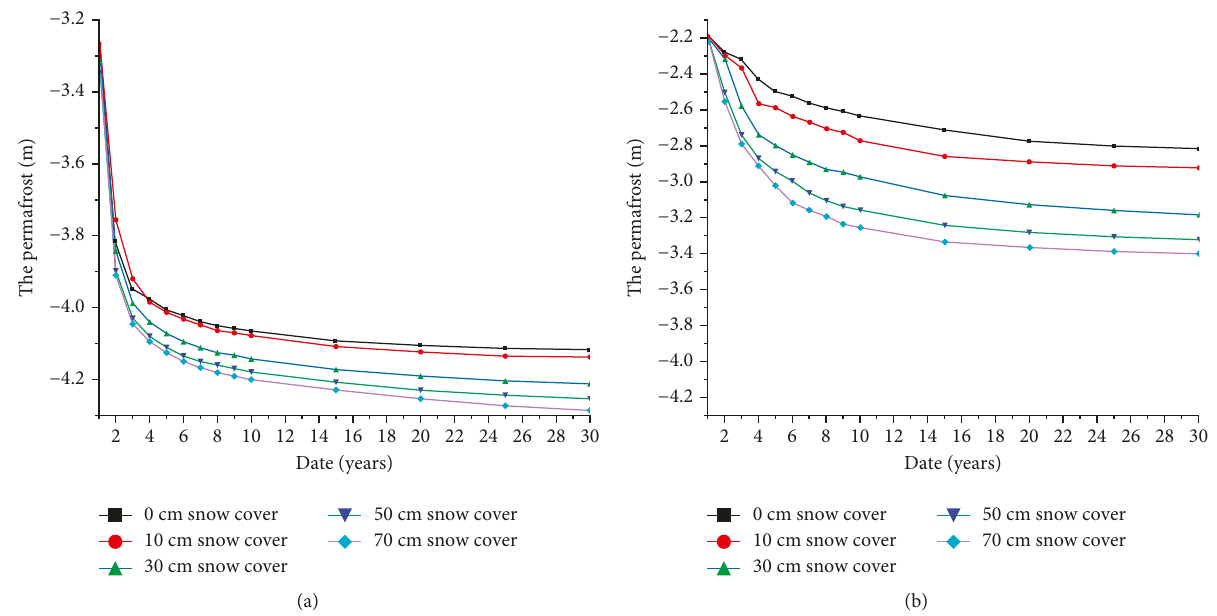
Figure 10: The frozen soil upper limit under different depths of snow cover, (a) Left road border, (b) Right road